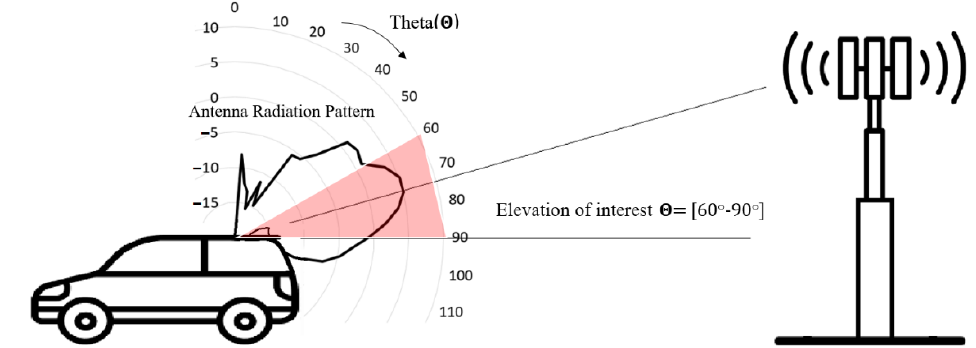
Figure 2. Automotive radiation pattern requirement relative to cell tower.